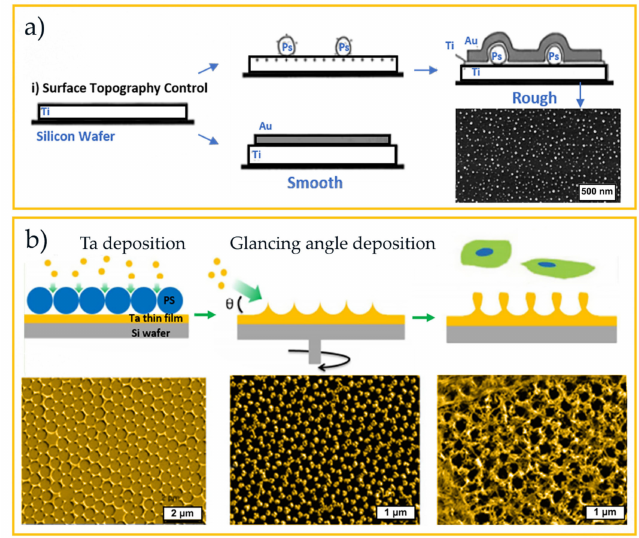
Figure 18. ( a ) Schematic illustration of prepared substrates with controlled nanotopography using CL and surface chemistry by alkanethiol self-assembly: i) smooth substrates were obtained by depositing titanium and gold layers onto silicon wafers; rough substrates were obtained by adhesion of negatively charged polystyrene colloidal particles to a smooth positively charged surface, followed by coating with a thin layer of gold. Adapted with permission from [193]. Copyright 2021 American Chemical Society. ( b ) Schematic structure of fabrication of ordered tantalum (Ta) nanotopographies using a combination of CL and glancing angle deposition techniques; and corresponding SEM images. Adapted with permission from [194]. Copyright 2021 American Chemical